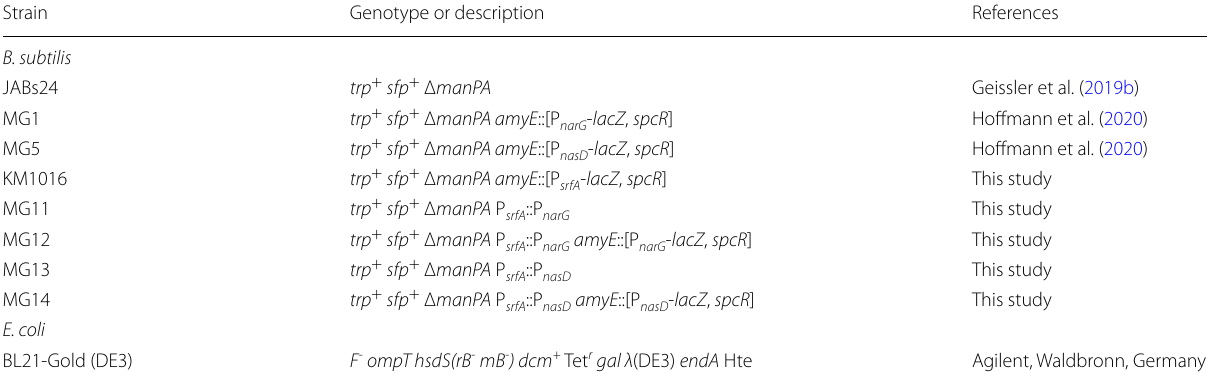
Table 1 Overview of strains used in the current study Strain Genotype or